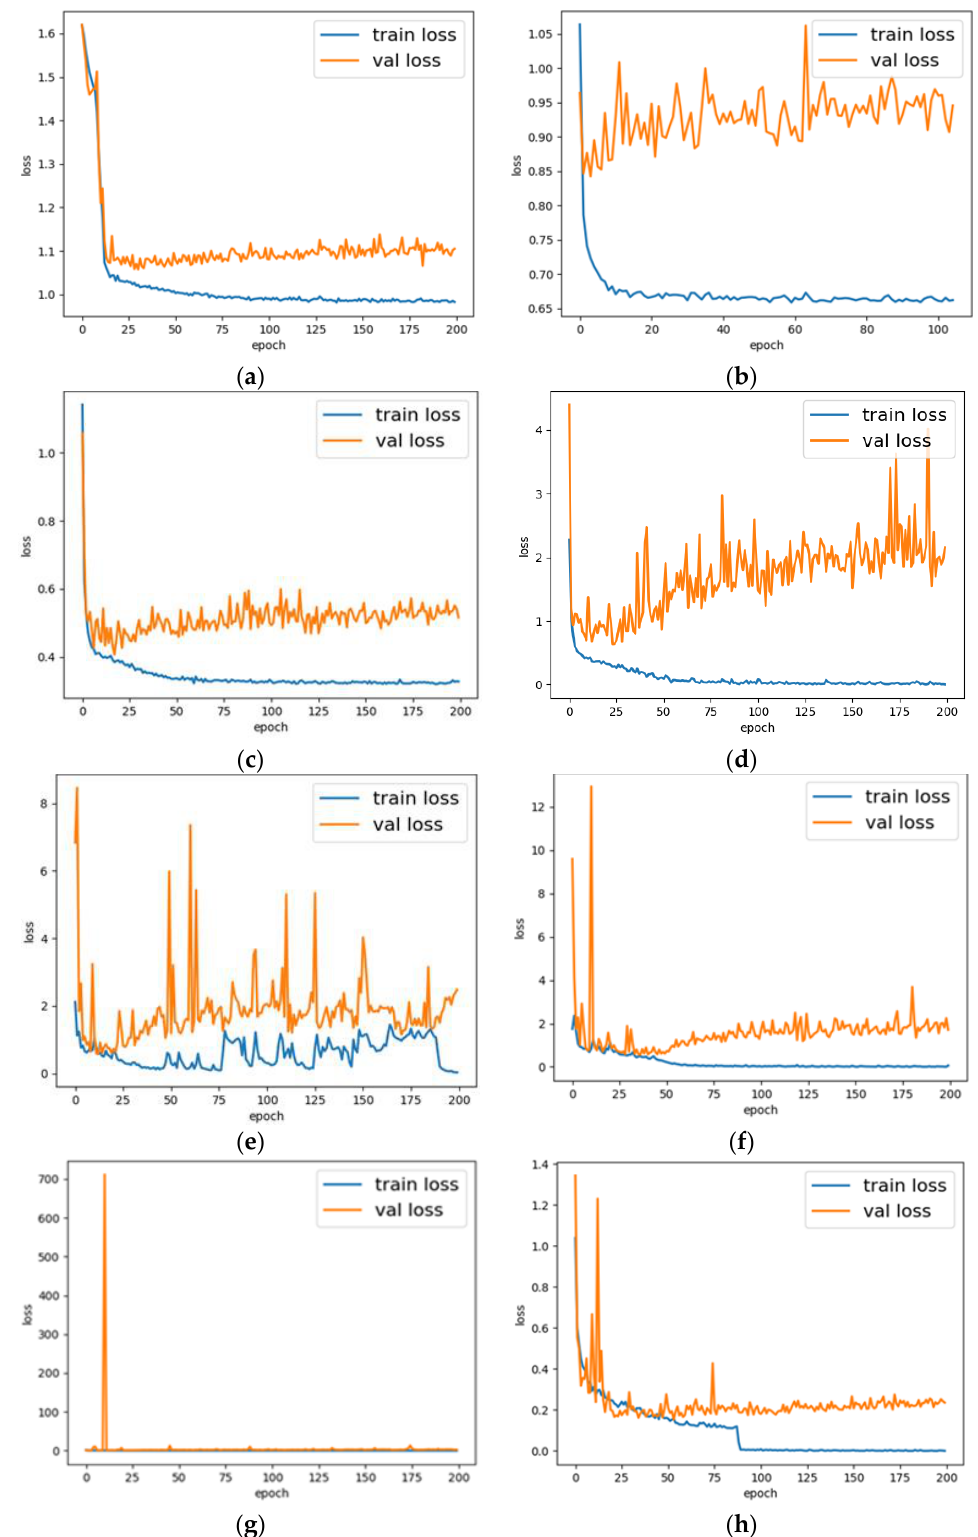
Figure 12. The loss curve of each model. ( a ) CapsNet; ( b ) CNN1 + Caps; ( c ) CNN2 + Caps; ( d ) VGG16; ( e ) ResNet18; ( f ) ResNet50; ( g ) ResNet101; ( h ) TongueCaps. In addition, after model testing is performed using a data set containing different brightness, while the accuracy, sensitivity, and specificity are obtained by calculating the